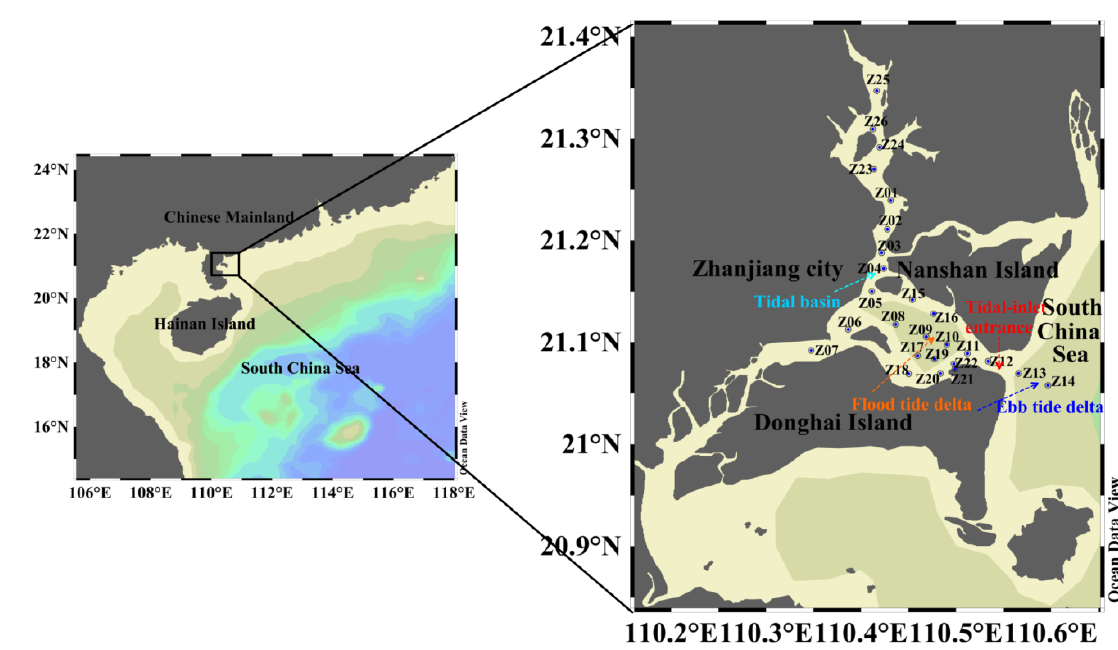
Figure 2. The study area showing sampling sites (Z1–Z26) in ZJB. ZJB can be roughly divided into four parts: the ebb-tide delta, tidal-inlet entrance, flood-tide delta, and tidal basin.